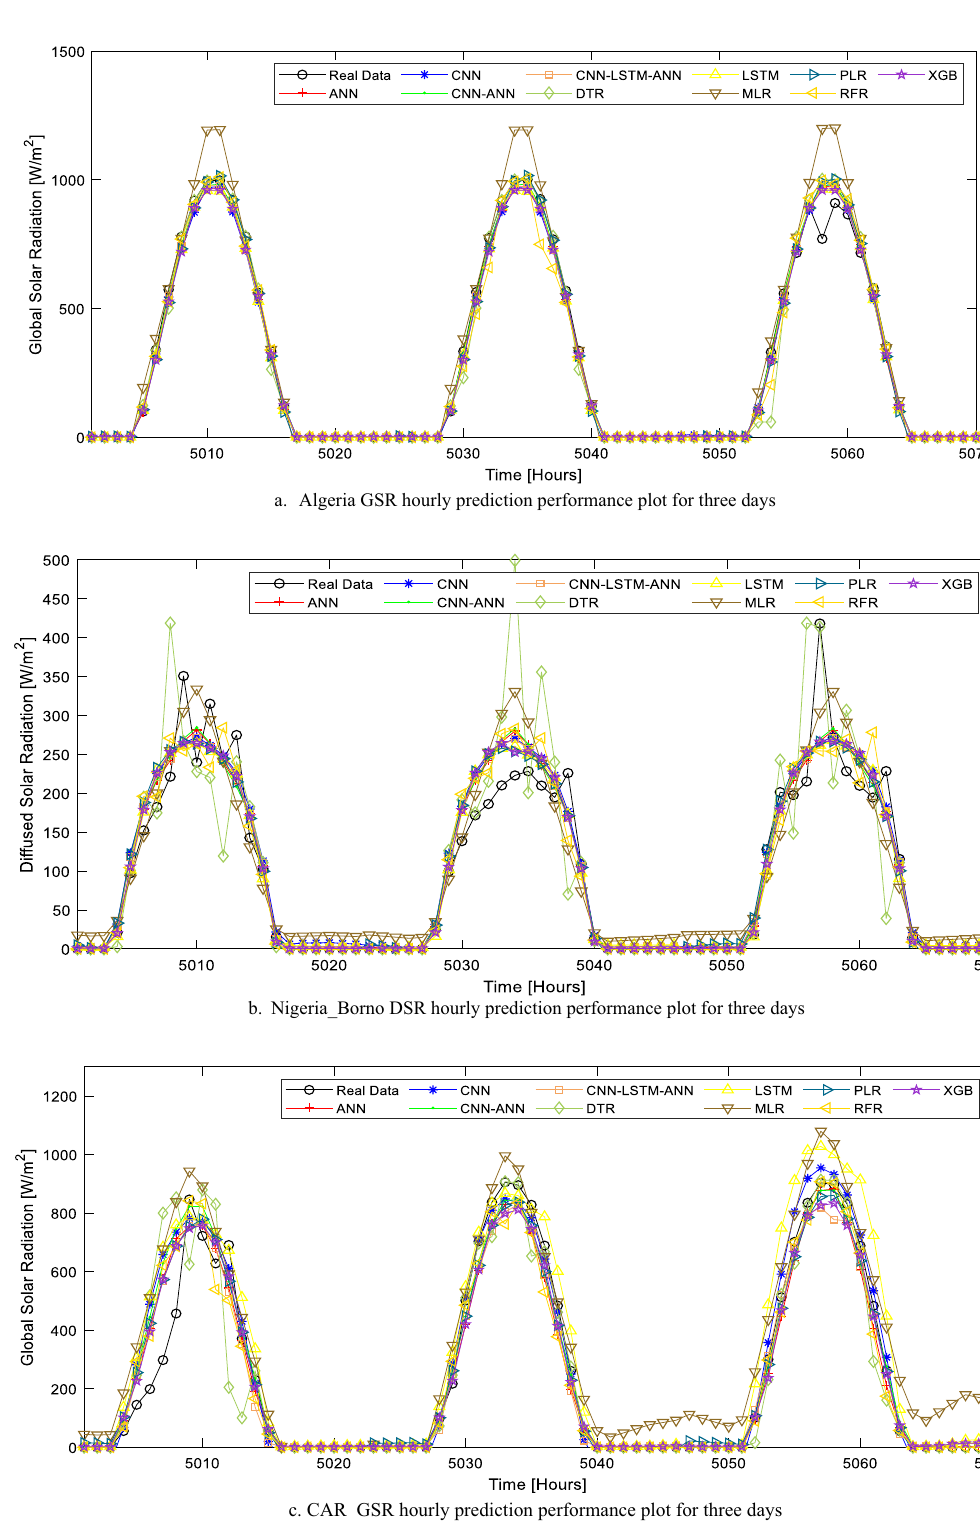
Figure 10. ( a ) Algeria GSR hourly prediction performance plot for three days. ( b ) Nigeria_Borno DSR hourly prediction performance plot for three days. ( c ) CAR GSR hourly prediction performance plot for three days. ( d ) Egypt GSR hourly prediction performance plot for three days. ( e ) SA GSR hourly prediction performance plot for three